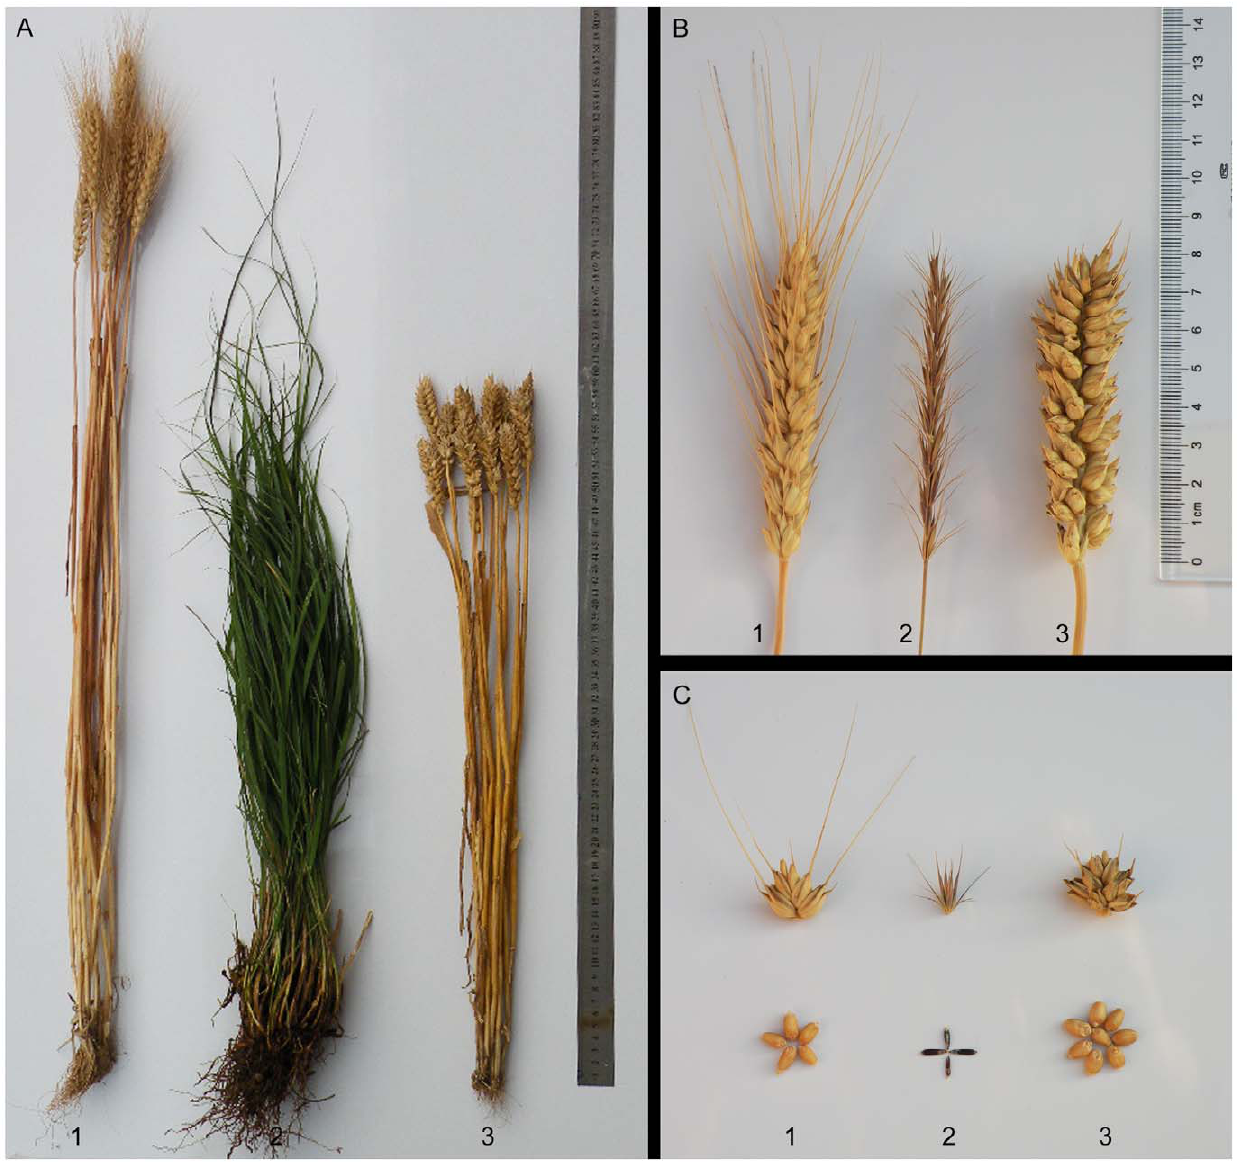
Figure 1. Morphological comparison of adult plants, spikes, spikelets, and seeds from disomic addition line 59-11 and its parents, wheat cv. 7182 and Psathyrostachyshuashanica . a adult plants; b spikes; c spikelets and seeds. 1 7182, 2 Psathyrostachys huashanica , 3 59-11.